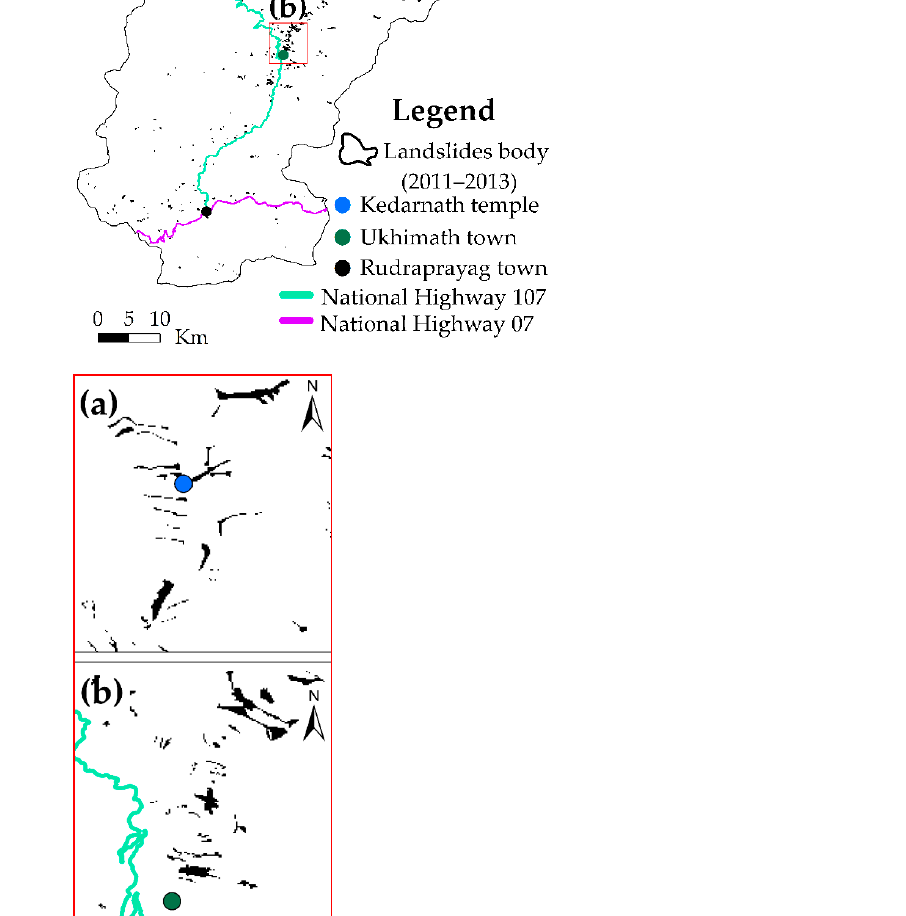
Figure 4. The distribution map of landslide body in the Rudraprayag district